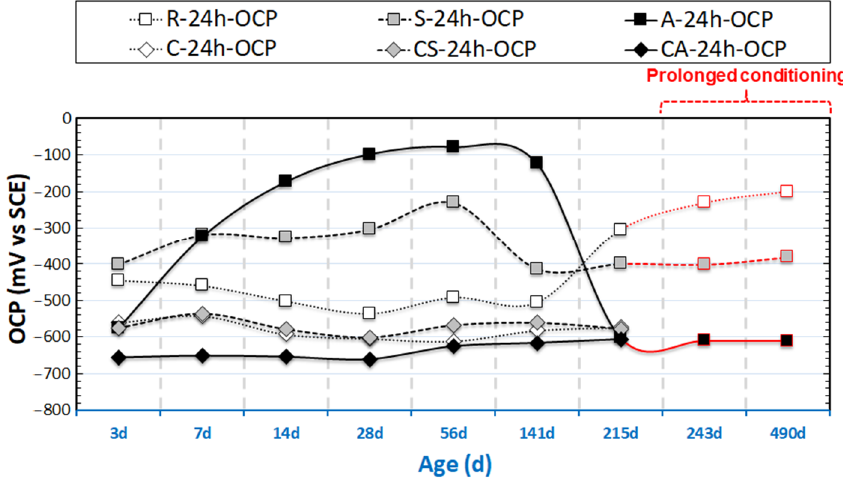
Figure 3. Open Circuit Potential (OCP) evolution of 24h-cured samples (R-24h: Reference; S-24h: Stray Current; A-24h: Anodic Polarization; C-24h: NaCl medium; CS-24h: NaCl + Stray Current; CA-24h: NaCl + Anodic Polarization).